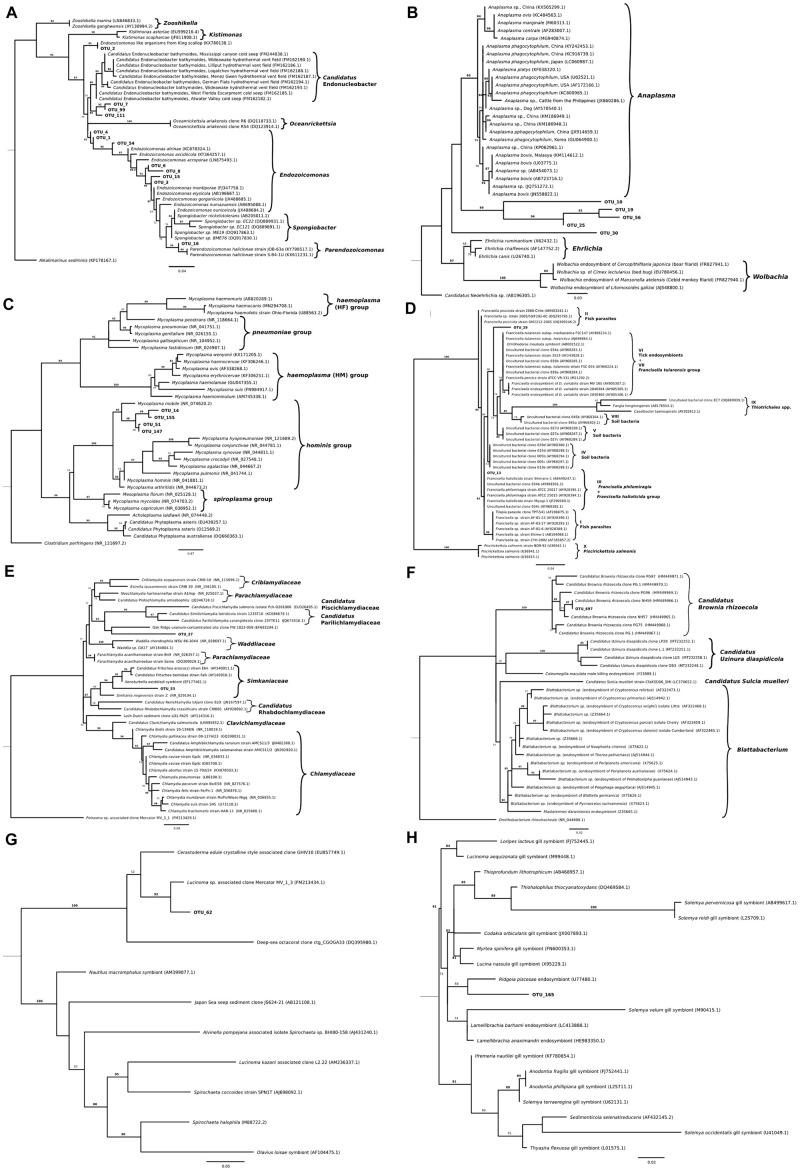
Maximum-likelihood trees showing phylogenetic relationships among partial sequences of the 16S rRNA gene of (A)
Endozoicomonas (222 bp alignment), (B)
Anaplasma, Ehrlichia and Wolbachia (221 bp alignment), (C)
Mycoplasma (261 bp alignment), (D)
Francisella (253 bp alignment), (E)
Chlamydia (251 bp alignment), (F) Bacteroidetes (256 bp alignment), (G) Spirochetes (255 bp alignment), and (H) thioautotrophic gammaproteobacterium (223 bp alignment) related representatives as well as Operational Taxonomic Units (OTUs) which were found to closely align. For all the trees, IQ tree, version 1.6.10, was parameterized to use the maximum likelihood general time-reversible model with equal substitution rates and base frequencies as well as four rate categories and allowing for a proportion of invariable sites. A thousand iterations of the Shimodaira–Hasegawa (SH)-like approximate likelihood ratio test was used for bootstrapping. Values on each node represent the percentage of bootstrap replicates which support a given position when using the SH-like approximate likelihood ratio test. Branch lengths represent the number of substitutions per a base. For OTU distribution among molluskan species/country refer to Table 1.